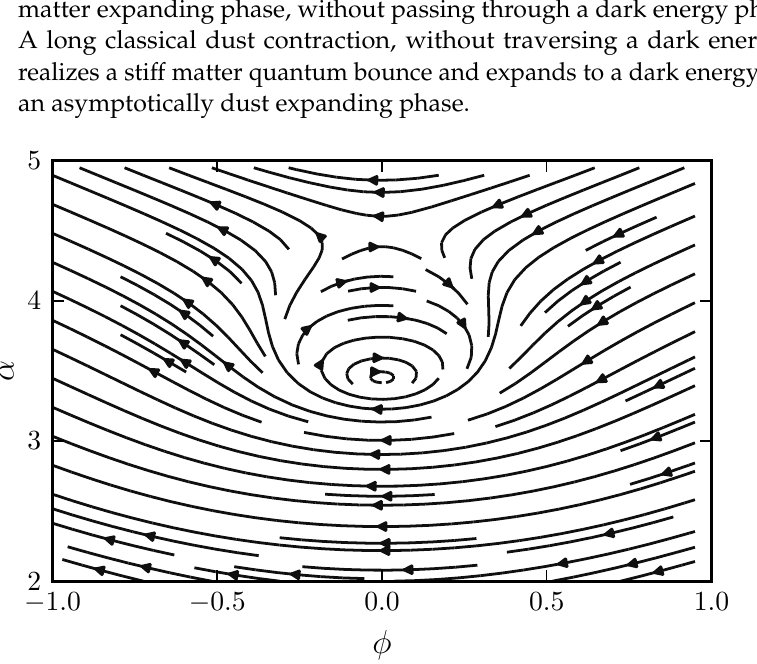
Figure 7. Phase space for the quantum bounce [95]. The bounces in the figure connect regions around S + in the contracting phase with regions around S